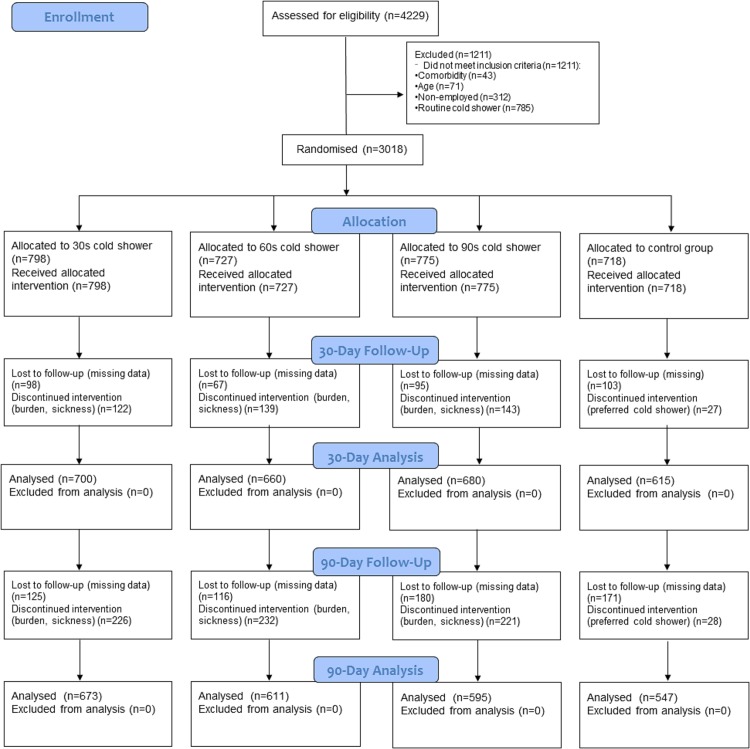
Study flow diagram.